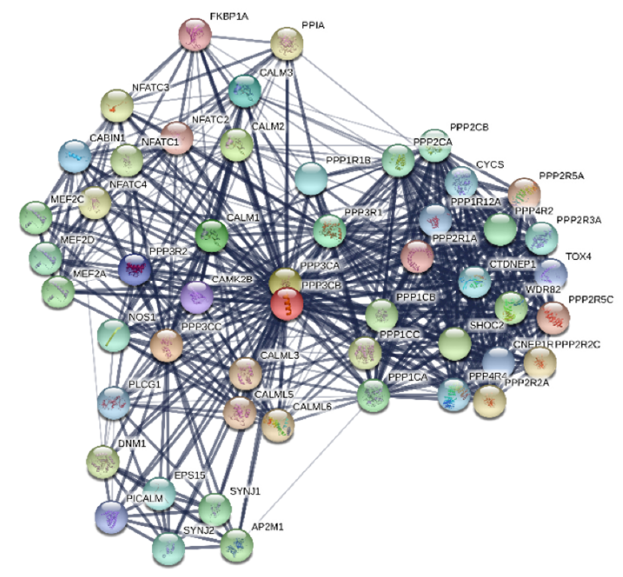
Figure A4. The interacting proteins of PPP3CB.